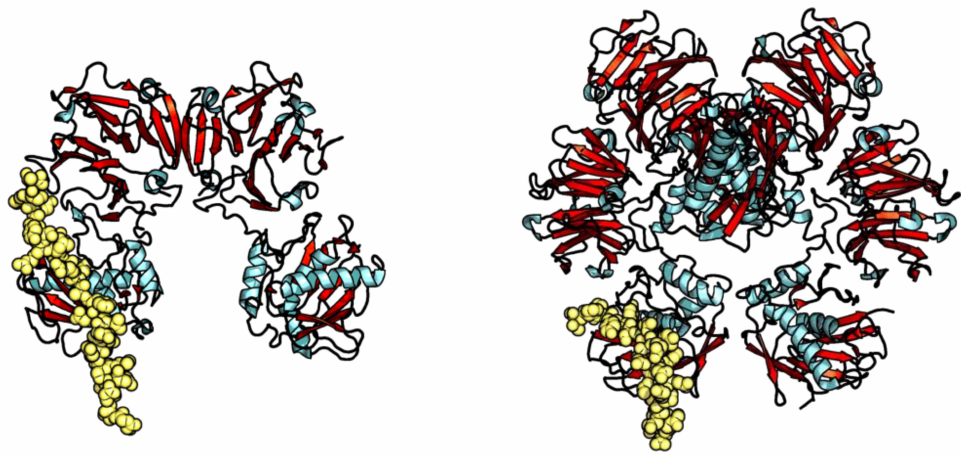
Figure 6. Human collagenase 3 (MMP-13) in two complexes with peptide F (PDB codes: 4FU4, 4G0D) [87]. The inhibitor molecules are presented as spheres. All figures of crystal structures were prepared in PyMOL [88].